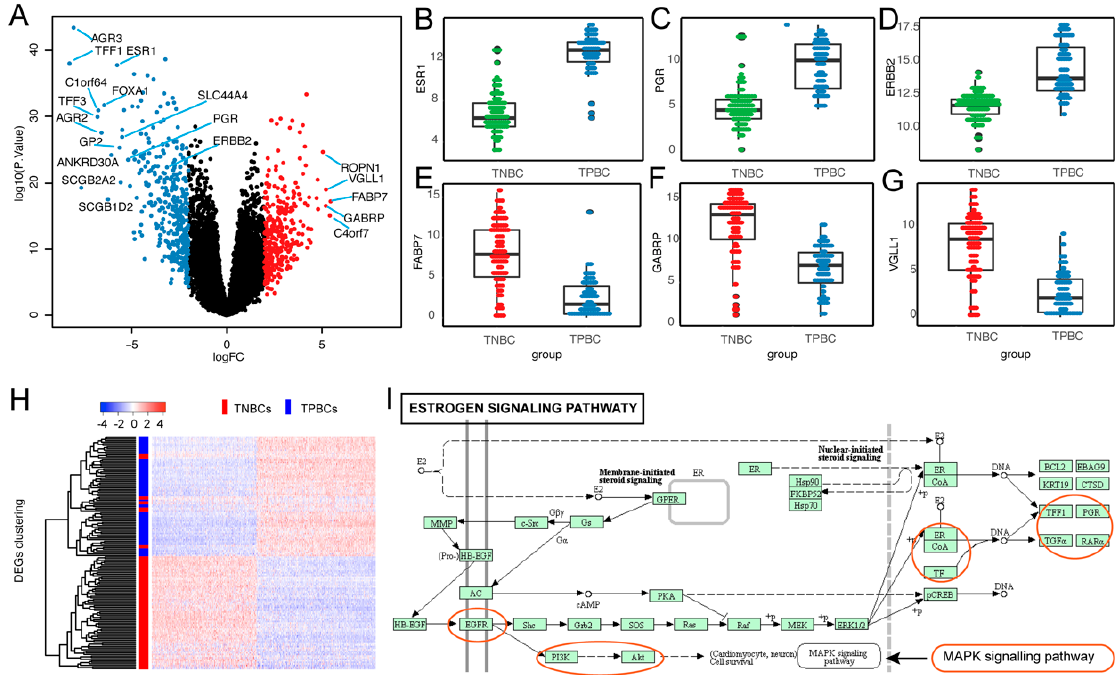
Figure 2. Differentially expressed genes (DEGs) in TNBC. ( A ) Volcano plot showing all 710 DEGs in TNBC. The red and blue dots represent the significantly up- and downregulated DEGs. ( B – G ) Box plots showing the distributions of downregulated ESR1 , PGR , and HER2 / neu genes and upregulated FABP7 , GABRP , and VGLL1 genes in TNBC tumors ( n = 84), compared with triple-positive breast cancer (TPBC) tumors ( n = 64). ( H ) Heatmap showing the expression profile of 84 TNBCs and 64 TPBCs across 710 DEGs. ( I ) Significantly enriched DEGs in estrogen signaling pathway.